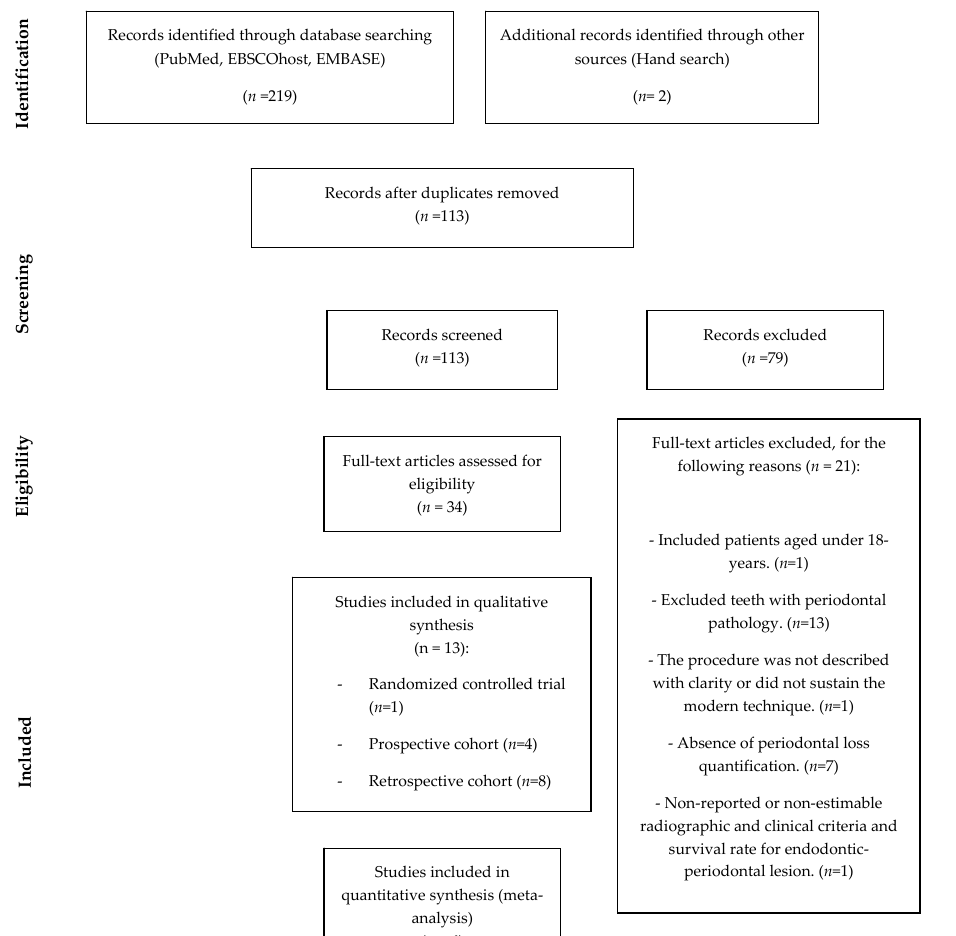
Figure 1. Flowchart of article selection method according to PRISMA